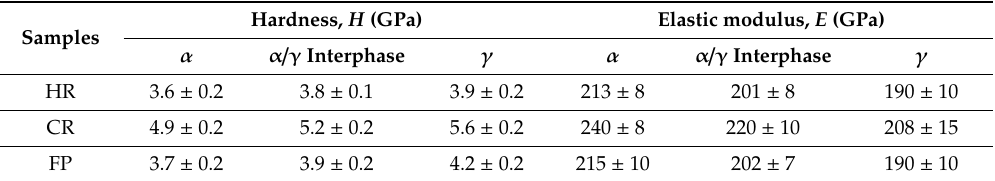
Table 2. Summary of H and E values of the defined phases in each processing condition of DSS determined from statistical analysis.